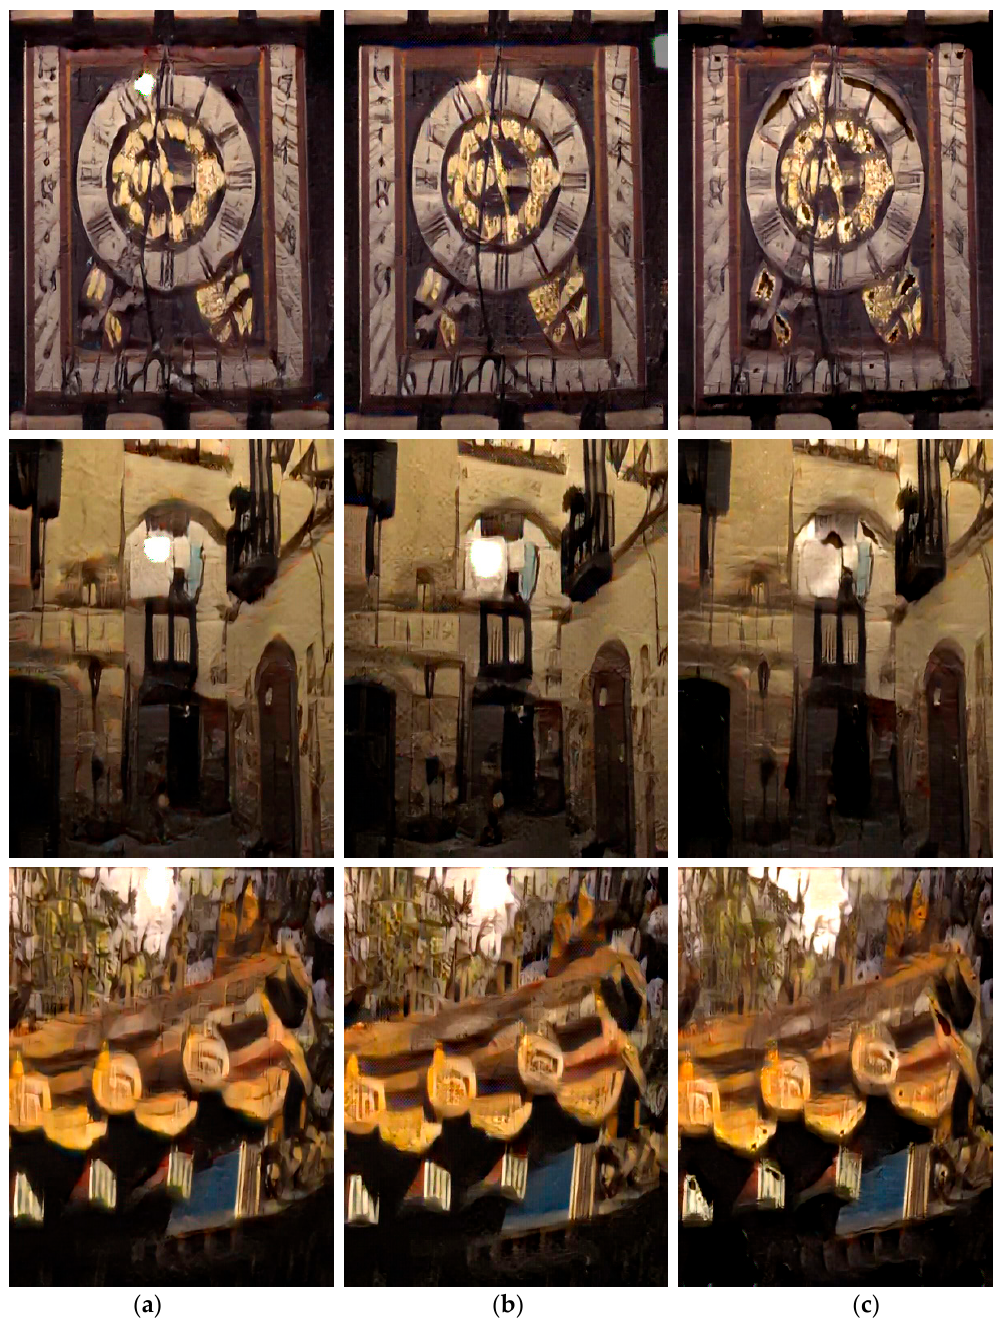
Figure 26. Generated images according to different λ values on Kohler dataset:. (a) λ =10 (b) λ =100 (c) λ =1000.